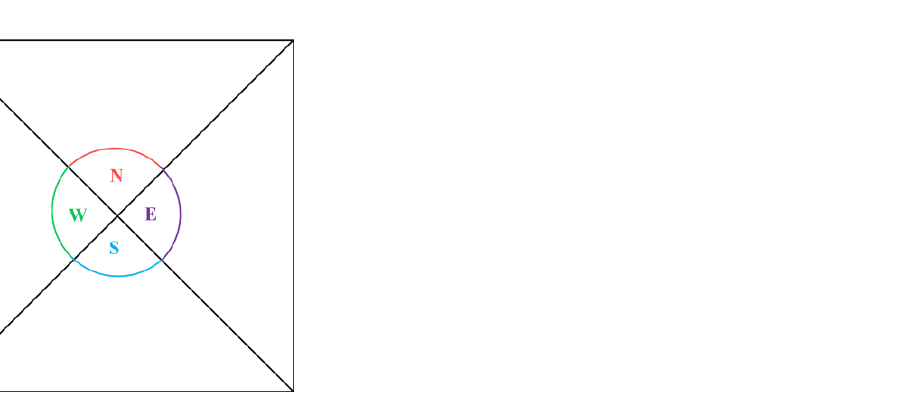
Figure 7. Examples of cargo ships in remote sensing images. ( a ) bulk carrier; ( b ) container; ( c ) tanker.